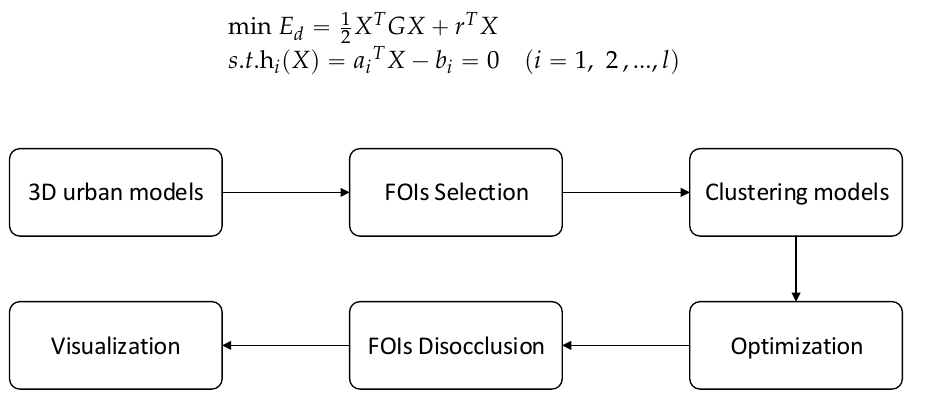
Figure 7. The framework of the presented method.